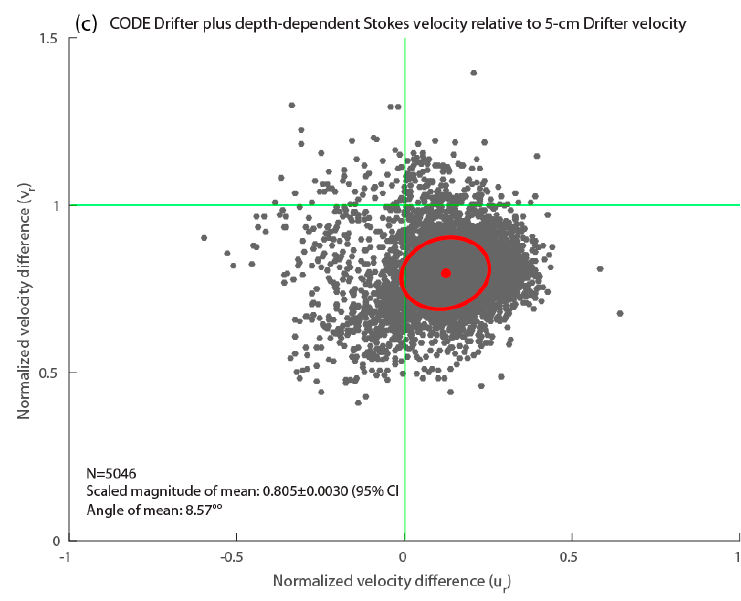
Figure 9. ( a ) CODE drifter velocity relative to co-located 5-cm drifter velocity ( u r , v r ), as calculated by Equation (1), but using a distance threshold of 4000 m for co-located drifter pairs. ( b ) Same as ( a ), except surface Stokes velocity computed by Equation (2) has been added to the CODE drifter velocity. ( c ) Same as ( b ), except the differential velocity of Stokes drift of the surface 4 cm over that averaged between 55 and 146 cm (the CODE drifter drogue depth) has been added to the CODE drifter velocity. The red dots are centroids of the scatter points and the red ellipses represent the standard deviations of the scatter points. Listed on each plot are the number of co-located observations (N), the angle clockwise from vector (0,1) to the centroid (mean), and the magnitude of the mean with 95% confidence interval.